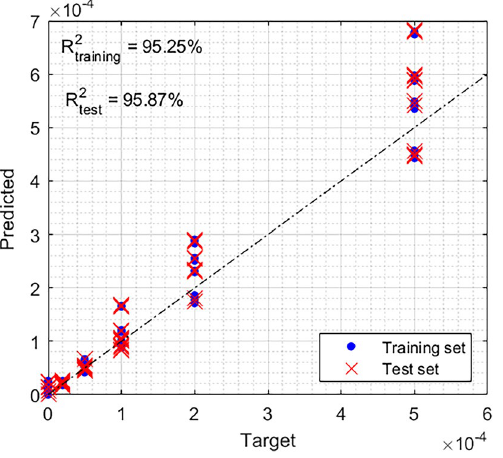
Figure 4. Results obtained on experimental Laser-Induced Fluorescence spectra. The figure shows the target vs predicted concentrations for both training and test